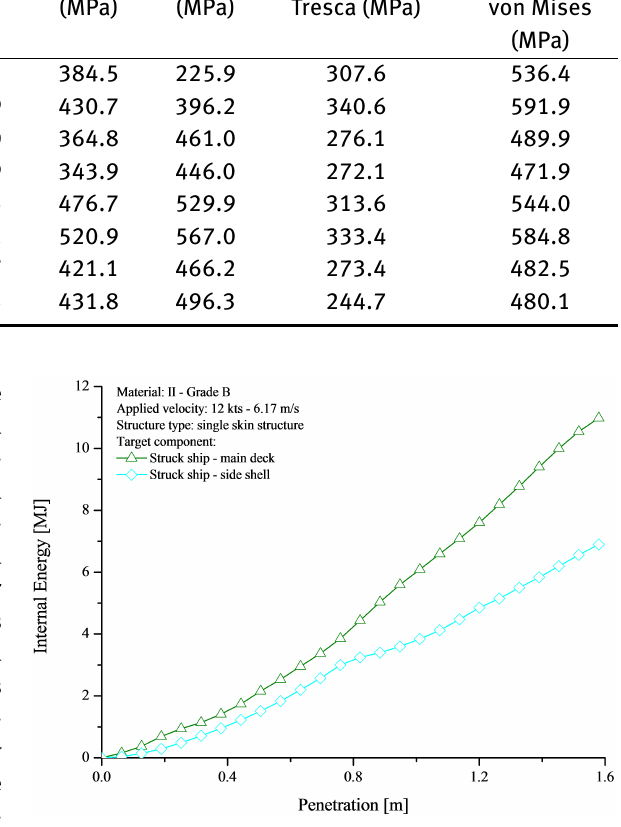
Figure 2: Behaviour of the internal energy vs. bow penetration: single skin